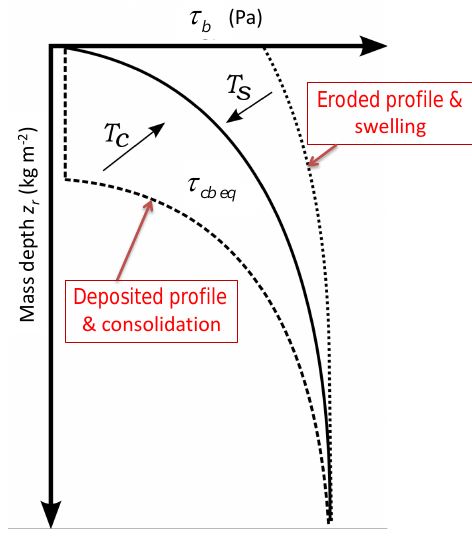
Figure 1. Conceptual diagram of consolidation and swelling (mod- ified from Rinehimer et al., 2008). The equilibrium bulk critical stress for the erosion profile, τ cbeq (z) , is shown as the solid line. The dotted line represents a critical shear stress profile following sedi- ment erosion. The dashed line is a profile after the deposition of sed- iment with a low τ c at the surface. The arrows indicate consolidation and swelling toward the equilibrium profile with the timescales T c and T s ,